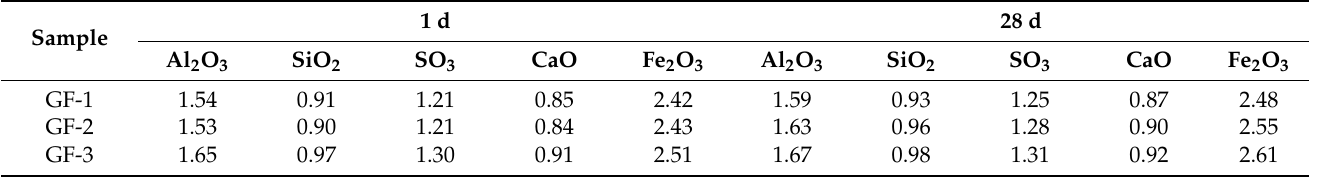
Table 6. The elemental structure of the cement